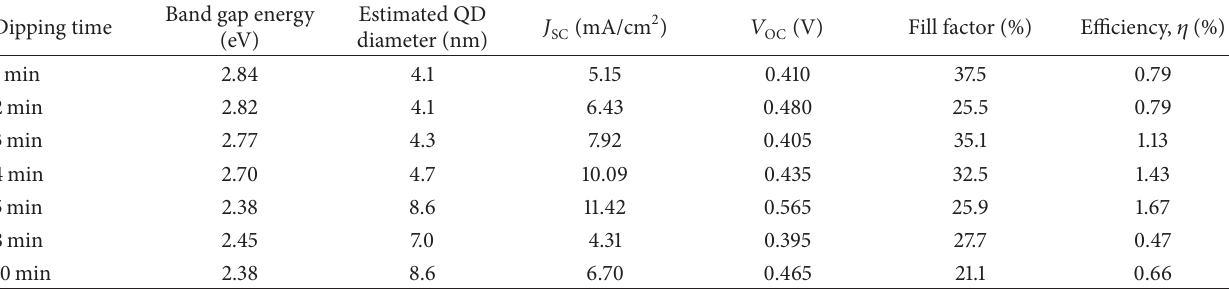
Table 5: The energy gap and size of QDs and QDSSC performance parameters for CdS QDs prepared using various dipping times. Band gap energy Estimated Dipping time (eV)